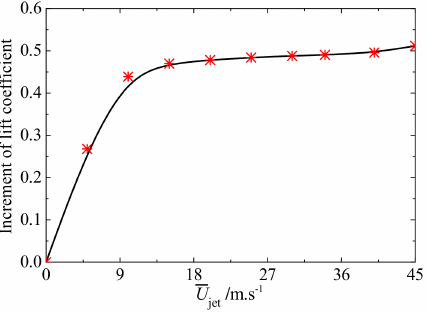
Figure 5. The influence of the blowing magnitude on the lift